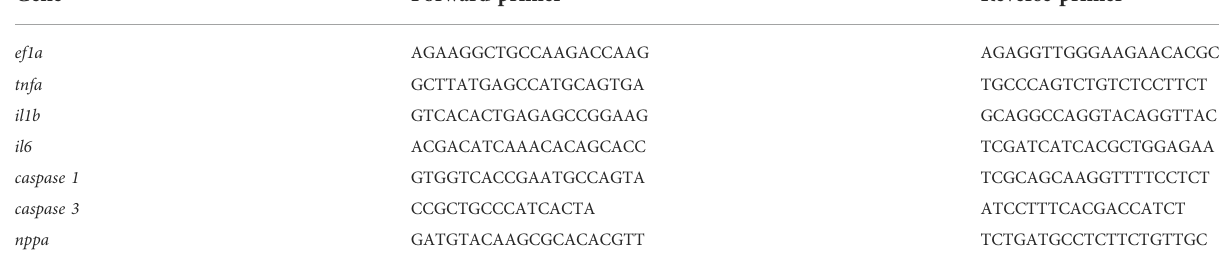
TABLE 1 The Sequences of all primers used in the